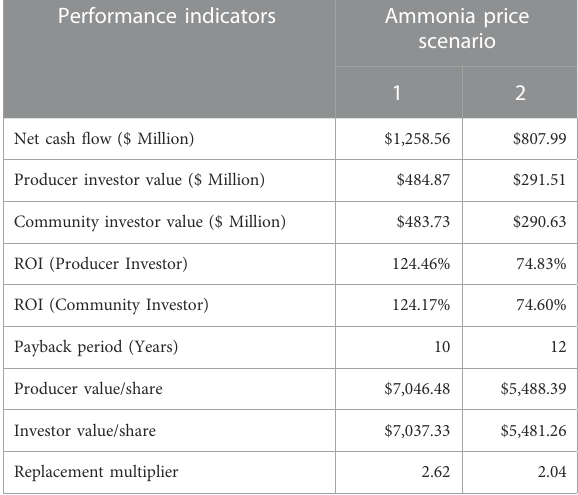
Figure 5. A time-based analysis of their variability showed that the average standard deviation increased towards the end of the series for both price series. Also, while the fi gure shows the two price series were different, their correlations coef fi cient